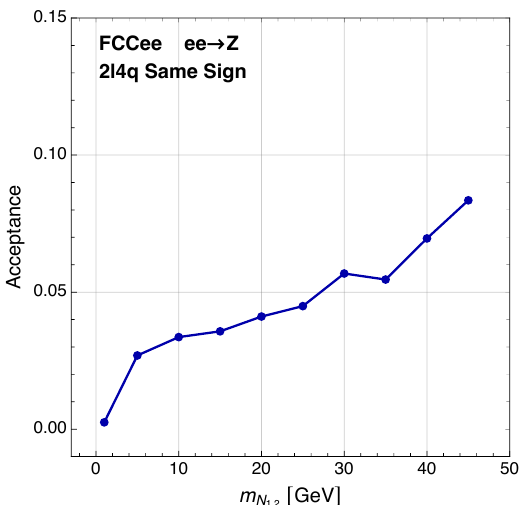
Figure 11 . Parton level acceptances for the 2 ‘ 4 q final state in the Z channel topology with a leptonically decaying Z boson and with the selection cut described in the main